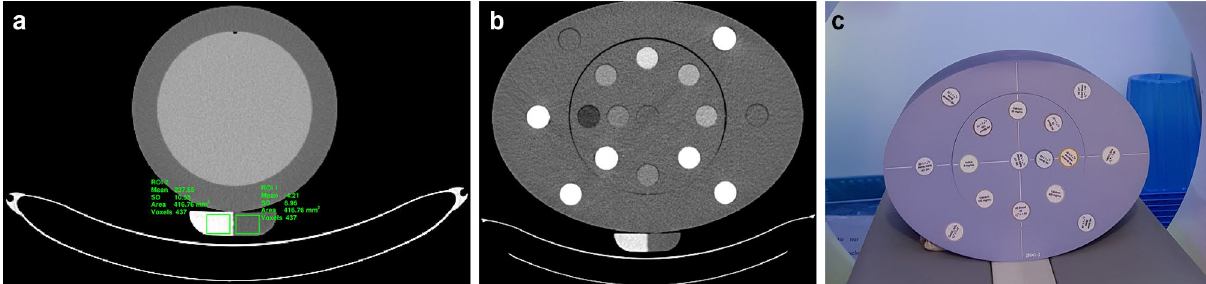
Figure 1. Image example from the calibration measurement ( A ) and the validation measurement with the MECT phantom ( B , C ). Images (A) and ( B ) were acquired on CT scanner #1 with a tube voltage of 120 kV p and reconstructed with filtered-back projection using a soft tissue kernel